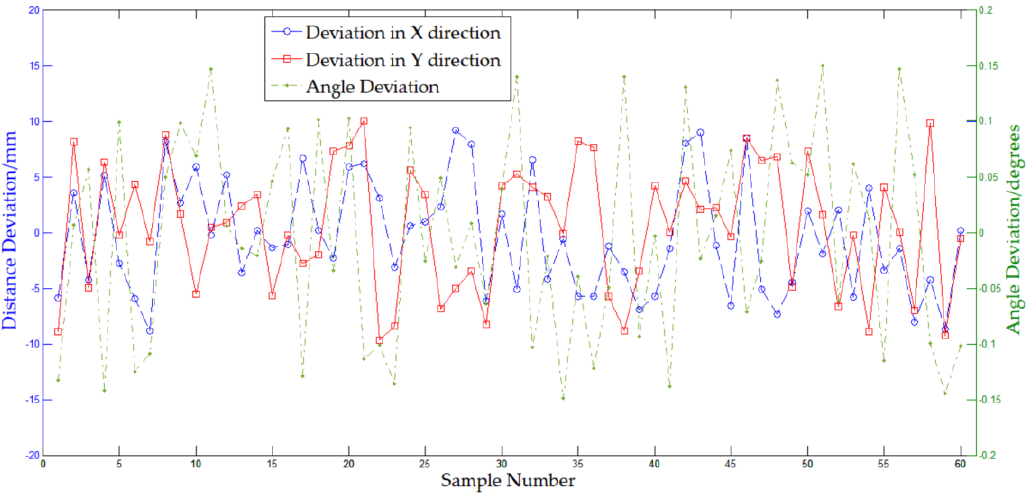
Figure 13. Distance and angle deviations of the repeated tests.